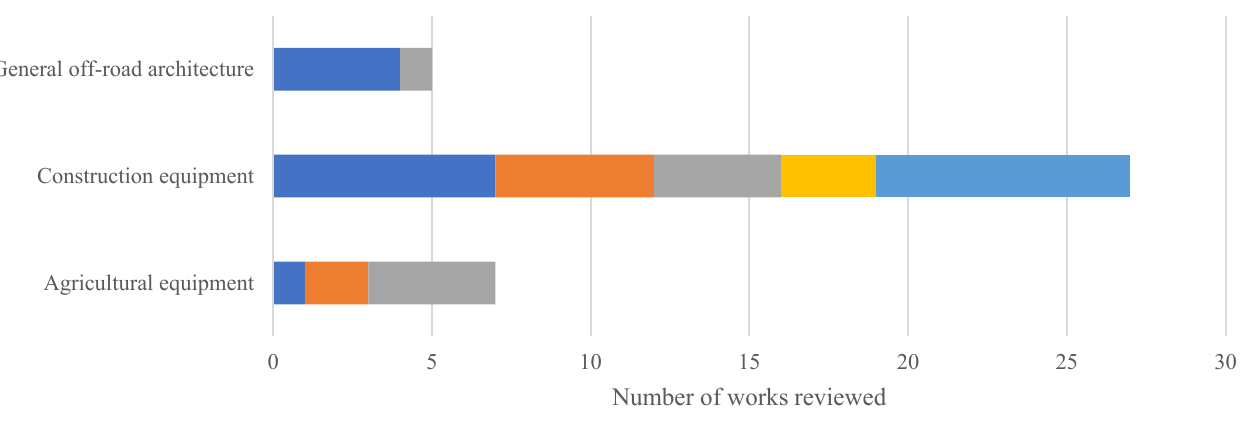
Figure 9. Comparative visualization of major works reviewed in Section 2: in the works conducted so far, emphasis has been given on both simulation and hardware implementation—both of them in many cases. For the construction sector, several commercially available vehicles fell into the interest of this review.